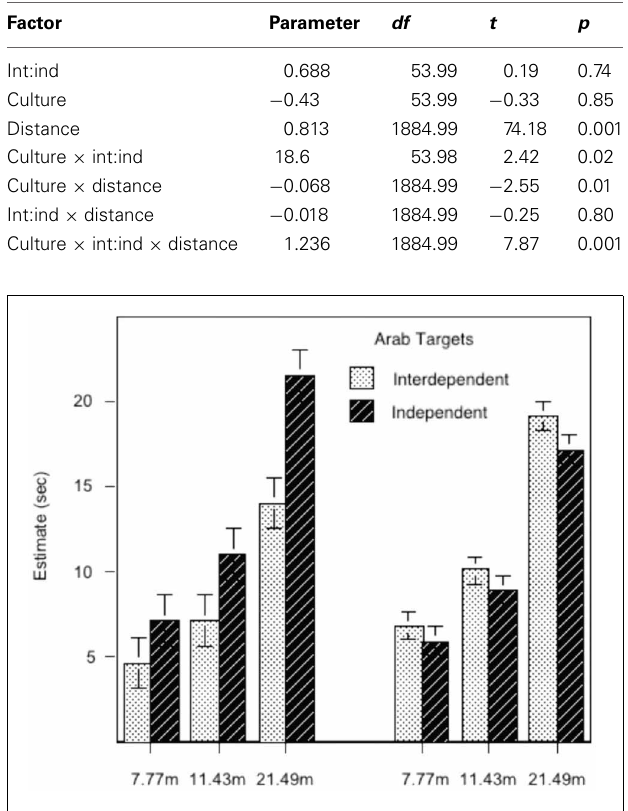
FIGURE 2 | Regression-estimated mean distance judgments (in estimated time to walk to target) to Arab-looking targets. Actual distance is indicated on the abscissa. Left: data from Arabs judging distance; Right: data from Americans judging